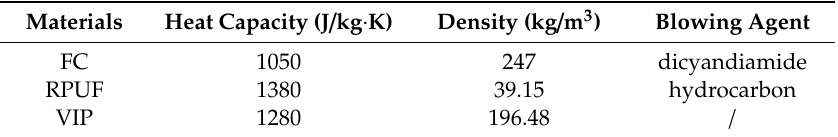
Table 1. Materials